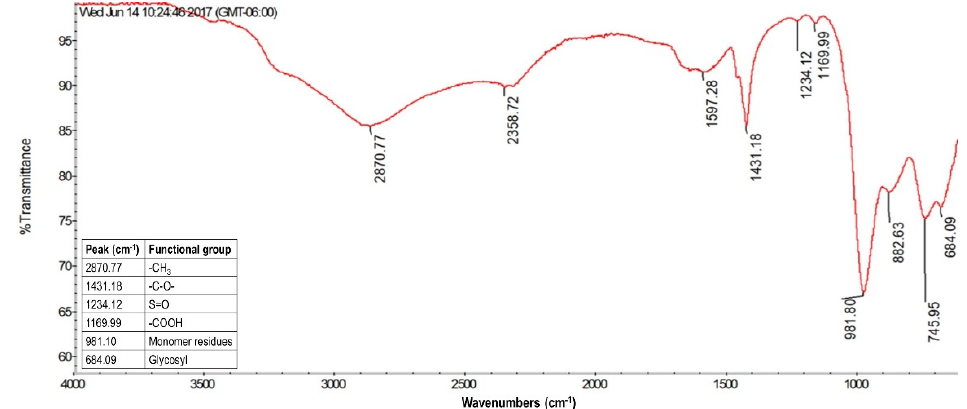
Figure 6. FTIR of biofilm produced by cultivation of C. maltosa SM4 under aeration of 3 L min − 1 and agitation speed 200 rpm.